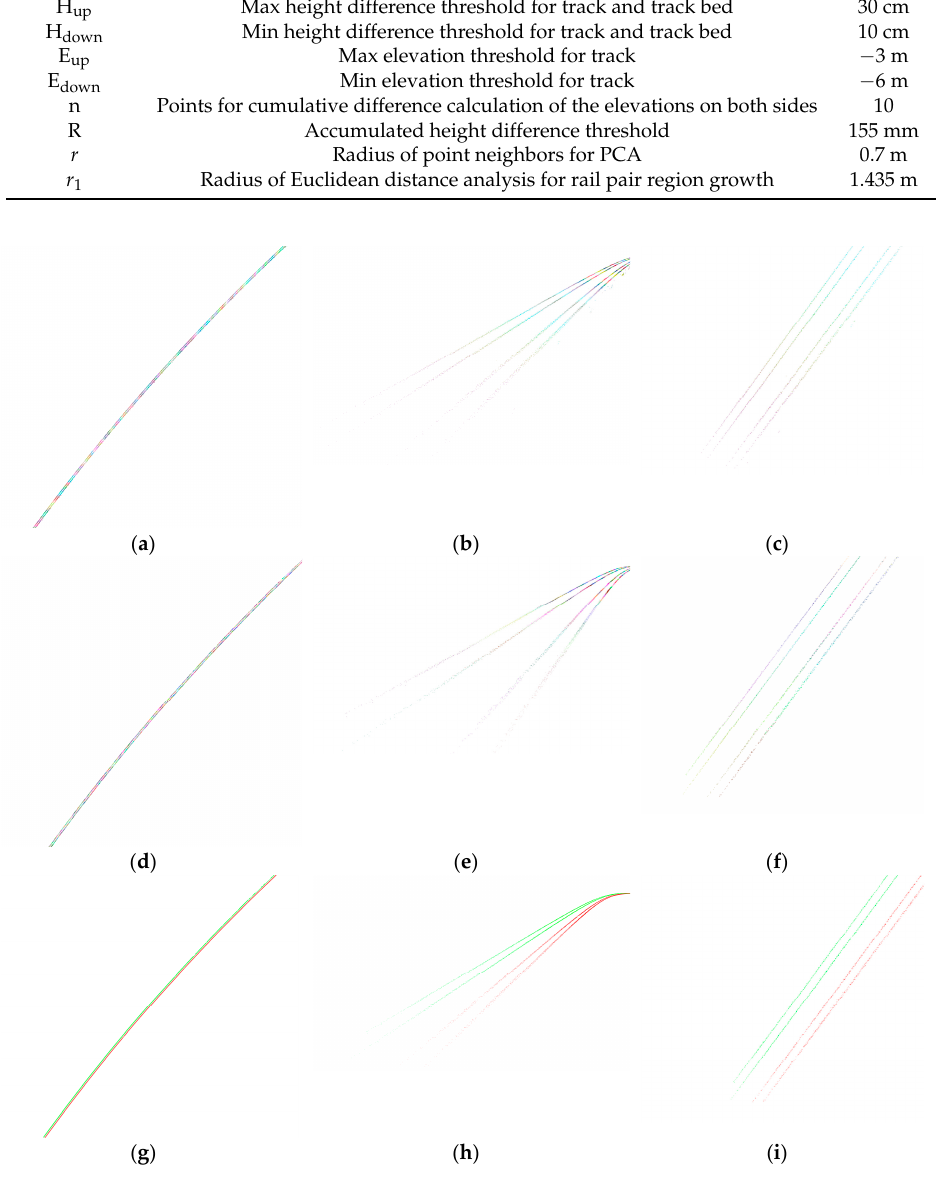
Figure 12. ( a ) Raw rail extraction results, top view; ( b ) view from start point; ( c ) view of start point; ( d ) PCA filter results, top view; ( e ) view from start point; ( f ) view of start point; ( g ) Label and connect results of two pairs of tracks, red lines indicate pair 1 and green lines are pair 2, top view; ( h ) view from start point; ( i ) view of start point.